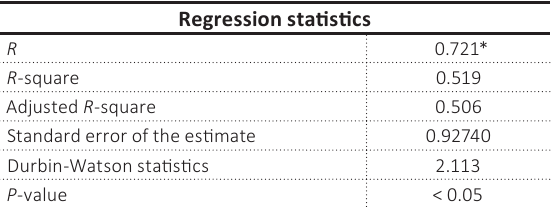
Table 5. Regression model